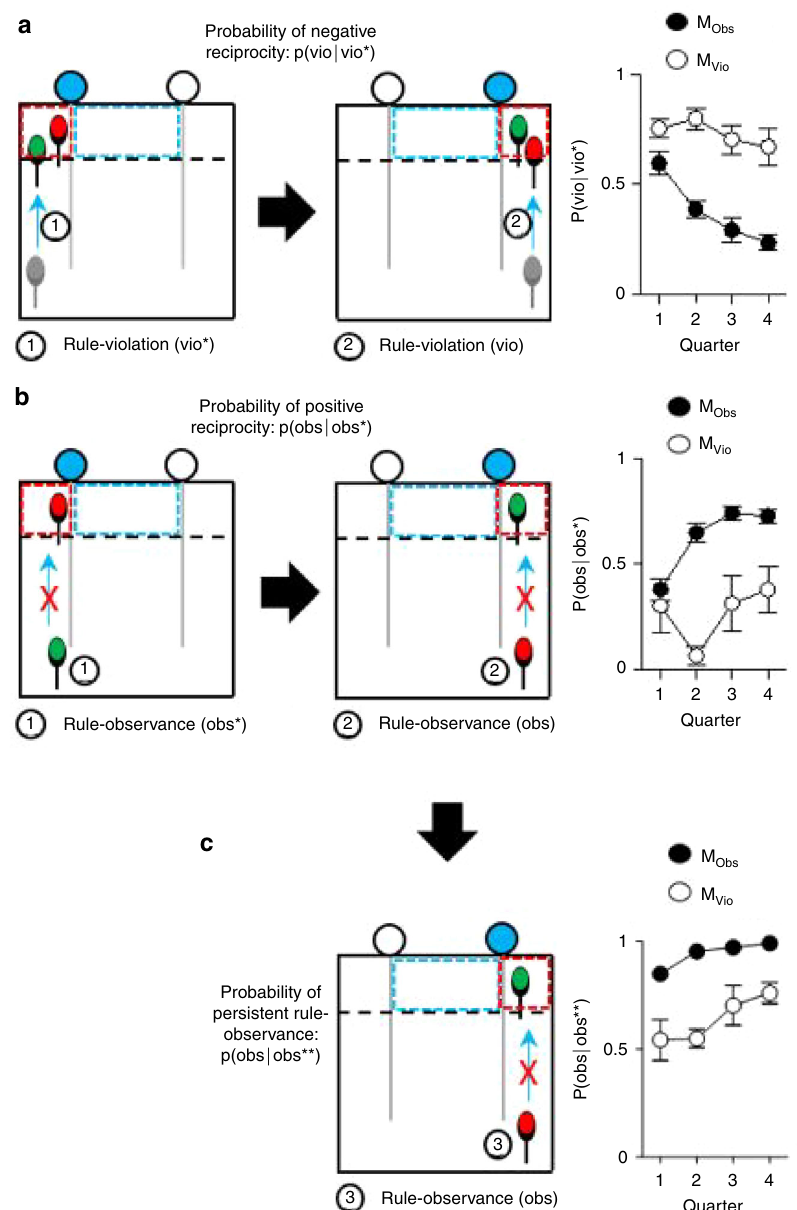
Fig. 6 Reciprocity in mutual rule-observance. obs, the number of cases that the opponent mouse observed the rule during the partner ’ s reward delivery in the current round. vio, the number of cases that the opponent mouse disrupted the partner ’ s reward in the current round. obs*(or vio*), the number of cases that the opponent mouse showed rule-observance (or rule-violation) behavior in the previous round. obs**, The number of cases that the mouse performed positive reciprocity in the previous round. a Rule-violation of a mouse after the other ’ s rule-violation in the previous round was de fi ned as negative reciprocity. Probability of negative reciprocity decreased (i.e., tolerance increased) in M Obs (One-way RM ANOVA, quarter, F 3, 45 = 12.8, P < 0.001) but not in M ’ s rule-observance in the previous round was de fi ned as positive reciprocity. Vio . b Rule-observance of a mouse after the other Probability of positive reciprocity increased in M Obs (one-way RM ANOVA, quarter, F 3, 45 = 19.8, P < 0.001) but not in M Vio . c Rule-observance of a mouse after it already showed positive reciprocity in the previous round is de fi ned as persistent rule-observance. Probability of persistent rule-observance at multiple unrewarded trials (i.e., partner rewarded.) was increased in both groups, but the level of M Vio remained lower than that of M Obs (two-way RM ANOVA, F1,24 = 252.30, P <